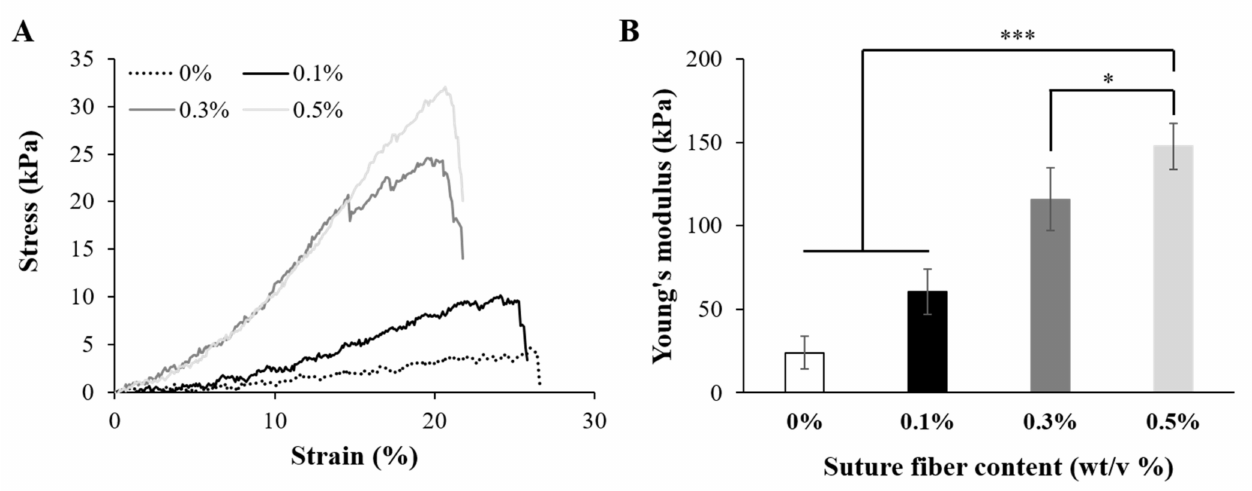
Figure 5. Mechanical properties of the 3D printed scaffolds (20 mm × 7 mm × 2 mm). ( A ) Tensile stress–strain curves of the 3D printed scaffolds with different suture fiber content. ( B ) Young’s modulus of the 3D printed scaffolds with different suture fiber content ( n = 7) (* p < 0.05 and *** p <